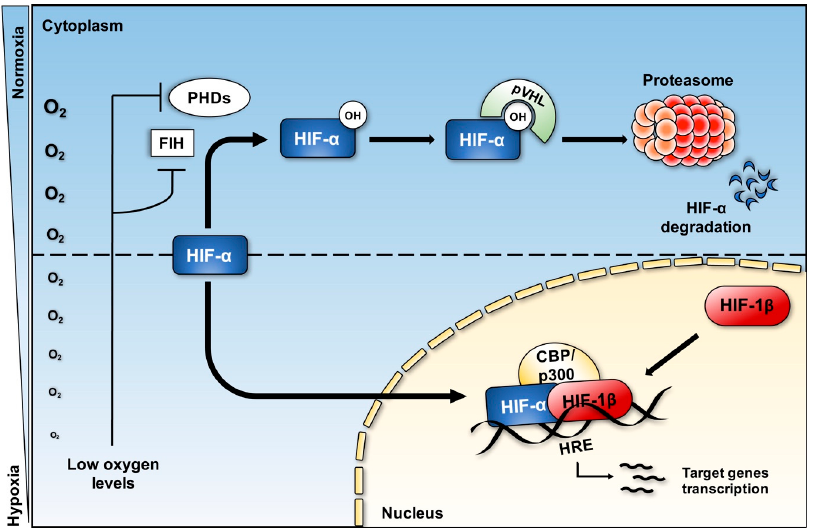
Figure 2. Activation of the Hypoxia Inducible Factor (HIF) pathway in response to hypoxia. HIF- α levels are controlled in normoxia by PHD-mediated hydroxylation (OH) and recognition by the E3-ligase complex containing the tumour suppressor pVHL. In hypoxia, Prolyl Hydroxylases (PHDs) and FIH are inhibited and HIF- α escapes VHL-dependent degradation. T-bars represent